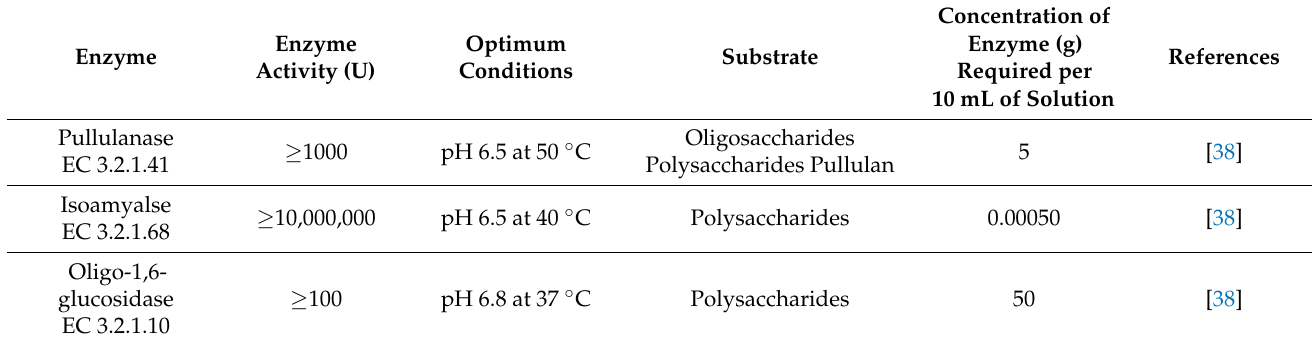
Table 2. Enzymatic activity and optimum conditions of starch debranching